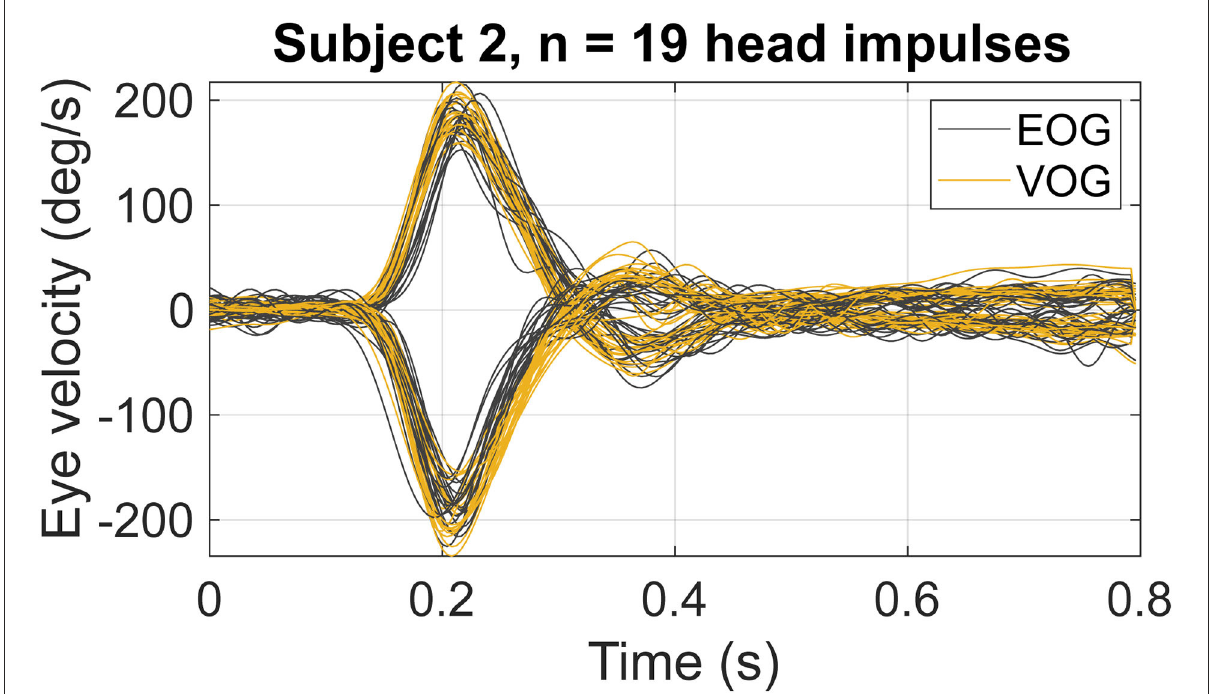
FIGURE2 An example of eye velocity traces in a single subject (subject 2), during 19 head impulses to the left (positive velocities) and to the right (negative velocities), recorded by EOG (gray traces) and VOG (yellow